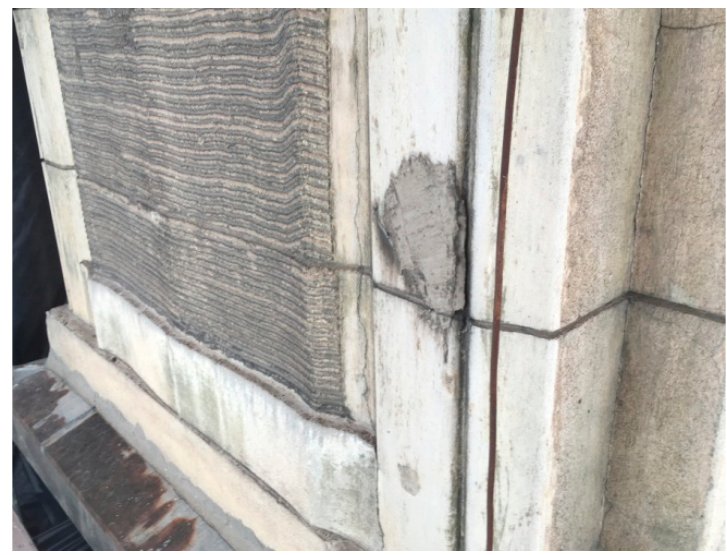
Figure 8. Cavities and areas replastered with secondary cement mortar.